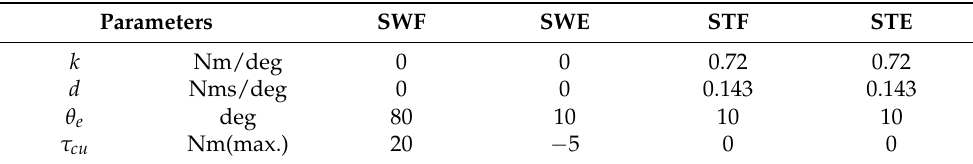
Table 2. Impedance parameters for the four gait modes using the knee-actuated-exoskeletal-gait orthosis (KAEGO).